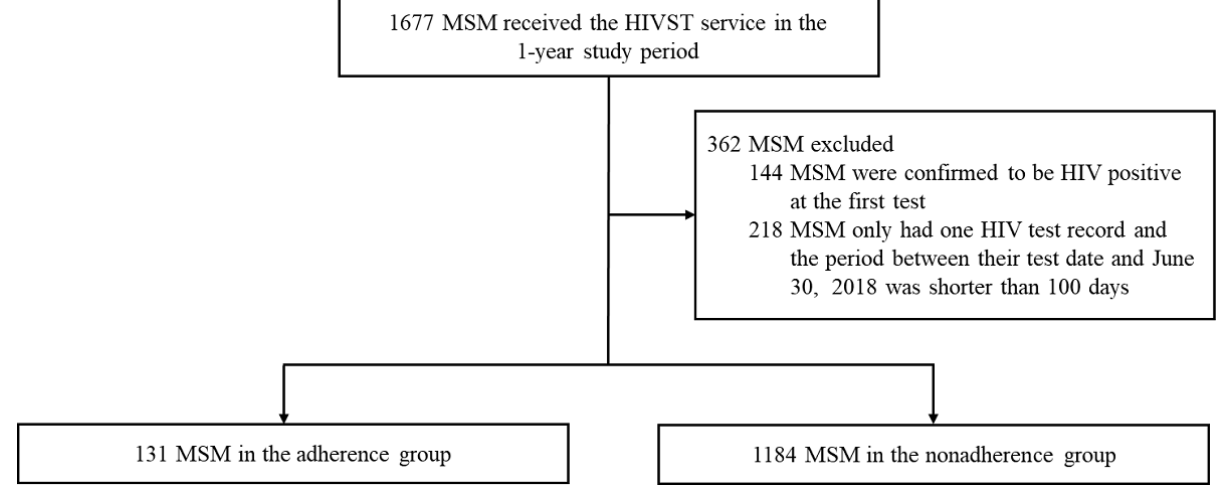
Figure 3. Study profile flowchart. HIVST: HIV self-testing: MSM: men who have sex with